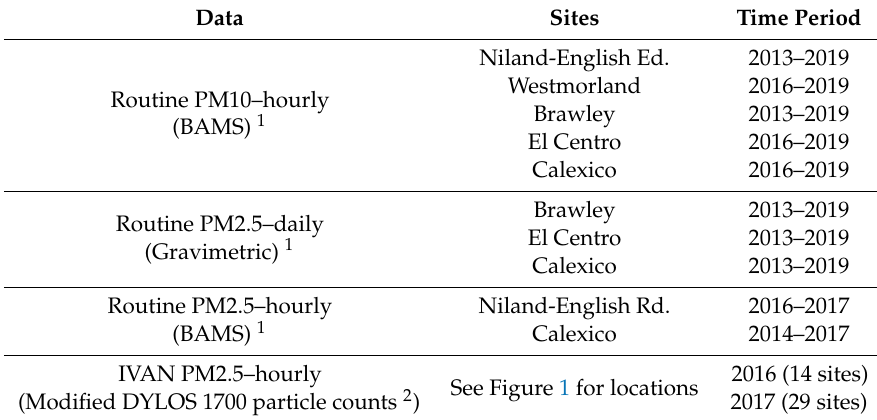
Table 1. Ground-level ambient-air PM data